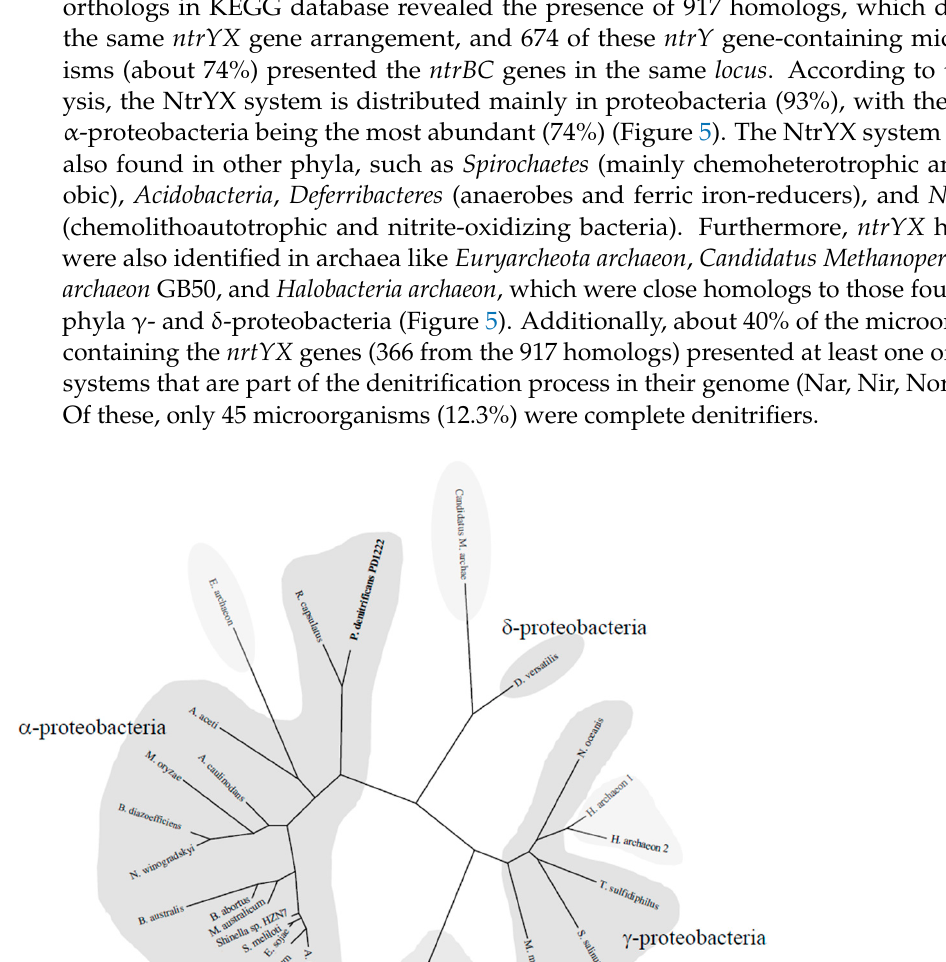
archaeon (NNG12573.1), and Halobacteria archaeon